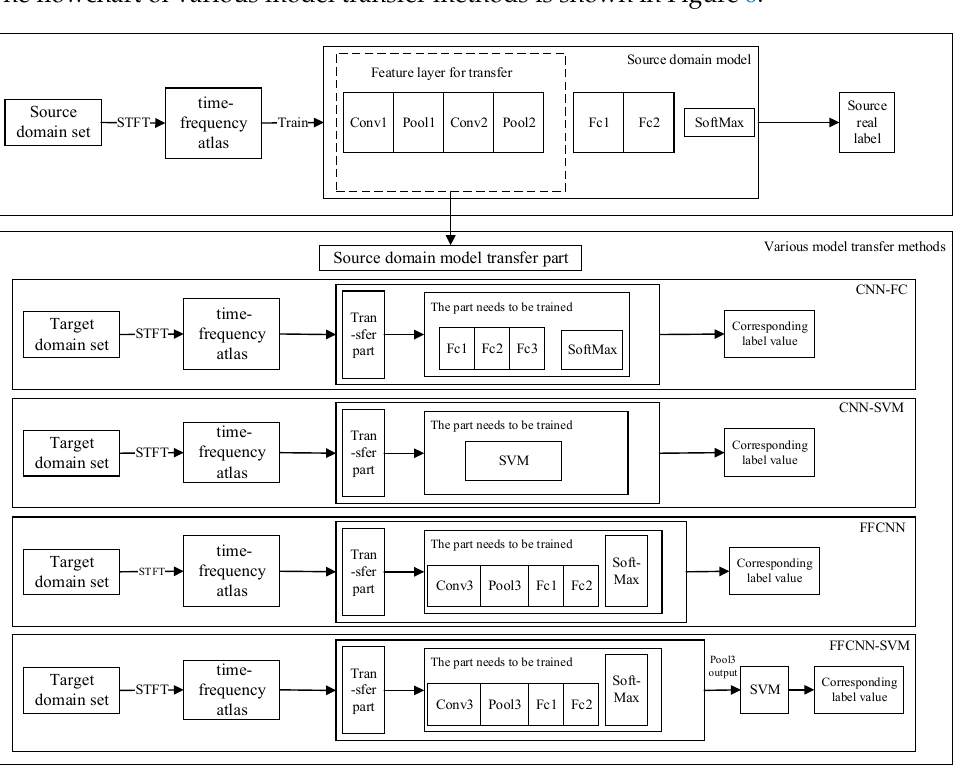
Figure 6. Flow chart of various model transfer methods.